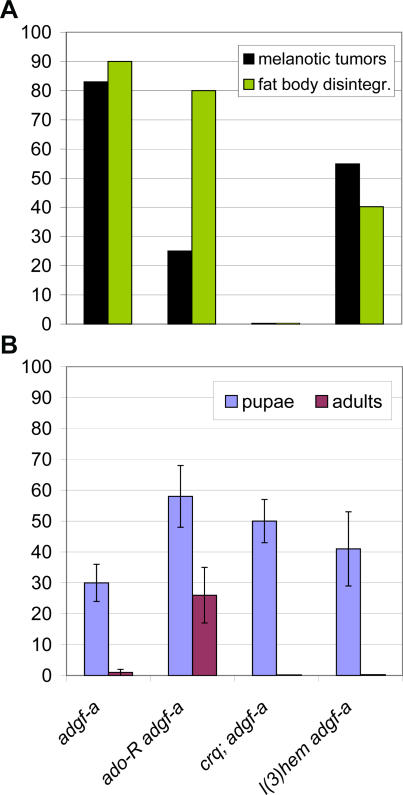
Suppression of the adgf-a Mutant Phenotype by Mutations in Other Genes(A) Percentage of late third-instar larvae with melanotic tumors (black bars) and fat body disintegration (green bars). The x-axis (which is shared with [B]), shows the genotype. The y-axis shows the percentage of larvae with tumors and fat body disintegration.(B) Survival rate of double mutants compared to single adgf-a mutant. The y-axis shows the percentage of the pupae (blue bars) and adult flies (purple bars) demonstrating the larval and pupal survival, respectively. Each experiment was repeated at least four times (with 20–30 animals in each vial) and the standard error is shown.